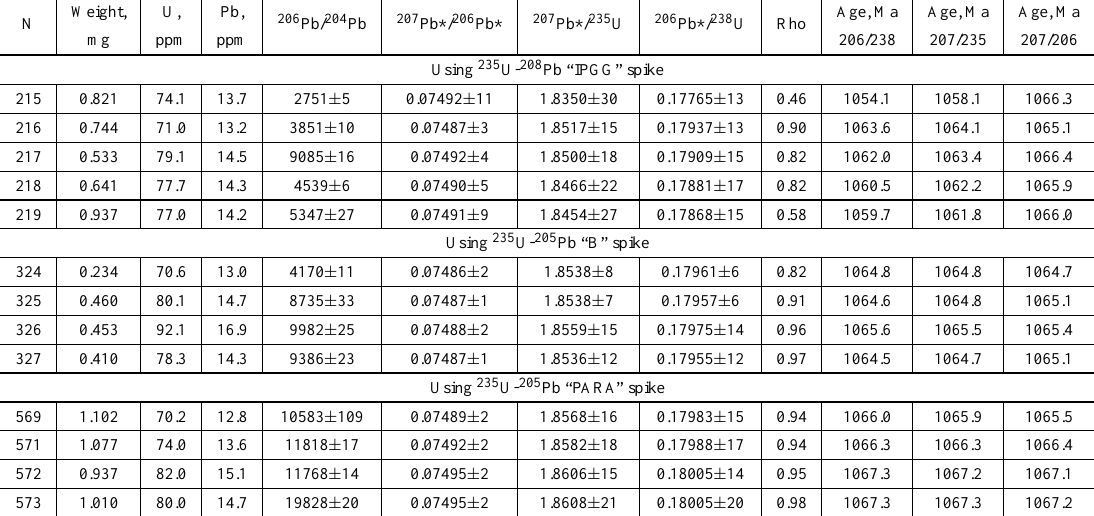
Results from U-Pb analyses of 91500 standard zircons.